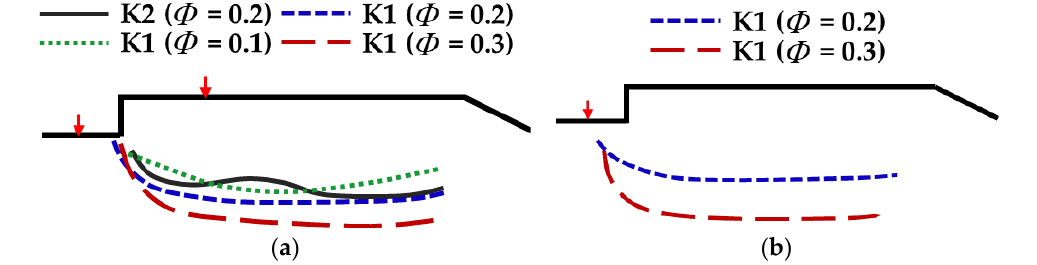
Figure 3. ( a ) Averaged flame brush; ( b ) the outermost edge of standard deviation images.